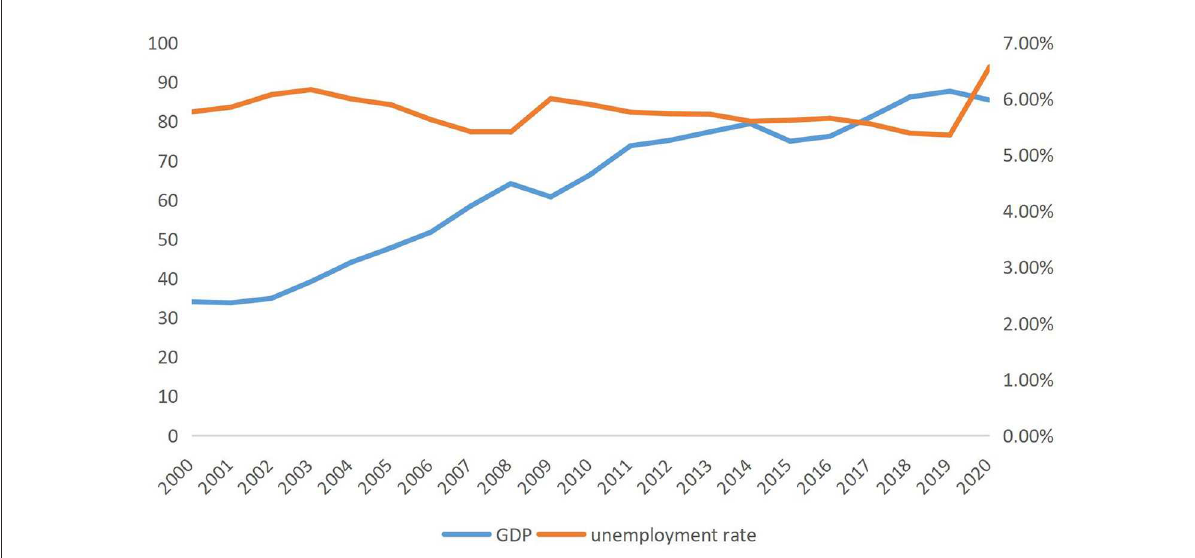
FIGURE1 World gross product (at current prices) and unemployment rate (modeled ILO estimates: % of the total labor force). Data source: CEIC